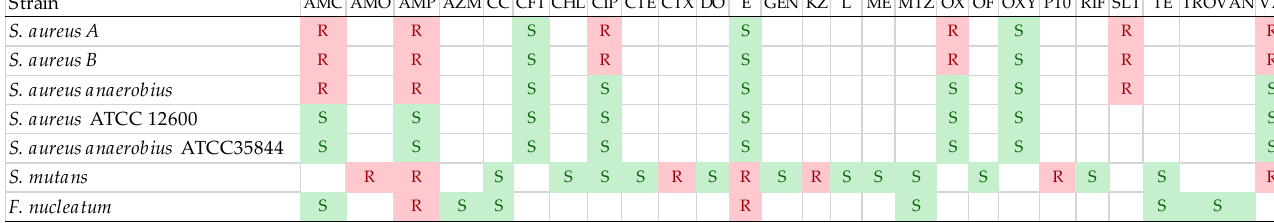
Figure 4. Antibiotic susceptibility profile of the strains used in the study (see in the text for antibiotic abbreviations).